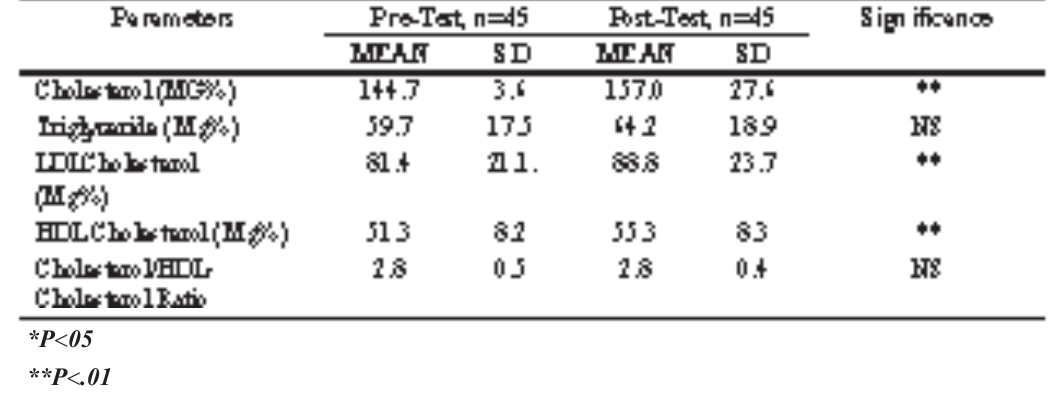
Table II: Lipid profiles of women boxers and changes after 6 weeks of training. (Mean ±